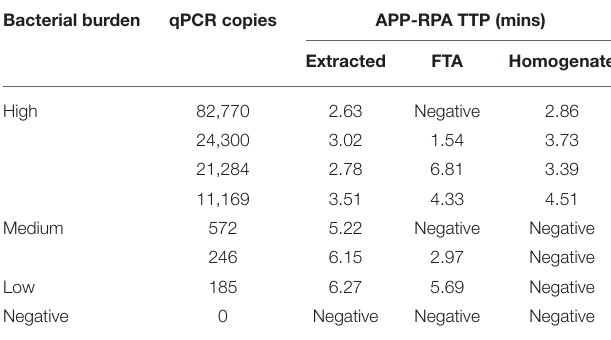
TABLE 3 | Performance of different extraction methods in